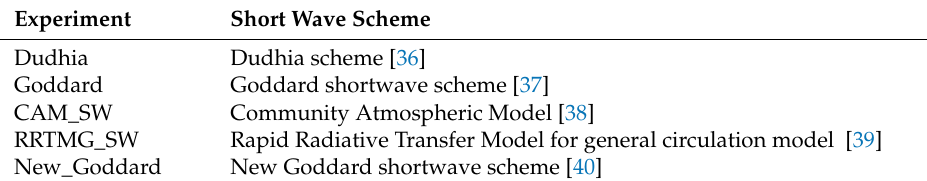
Table 1. Shortwave schemes included in the sensitivity